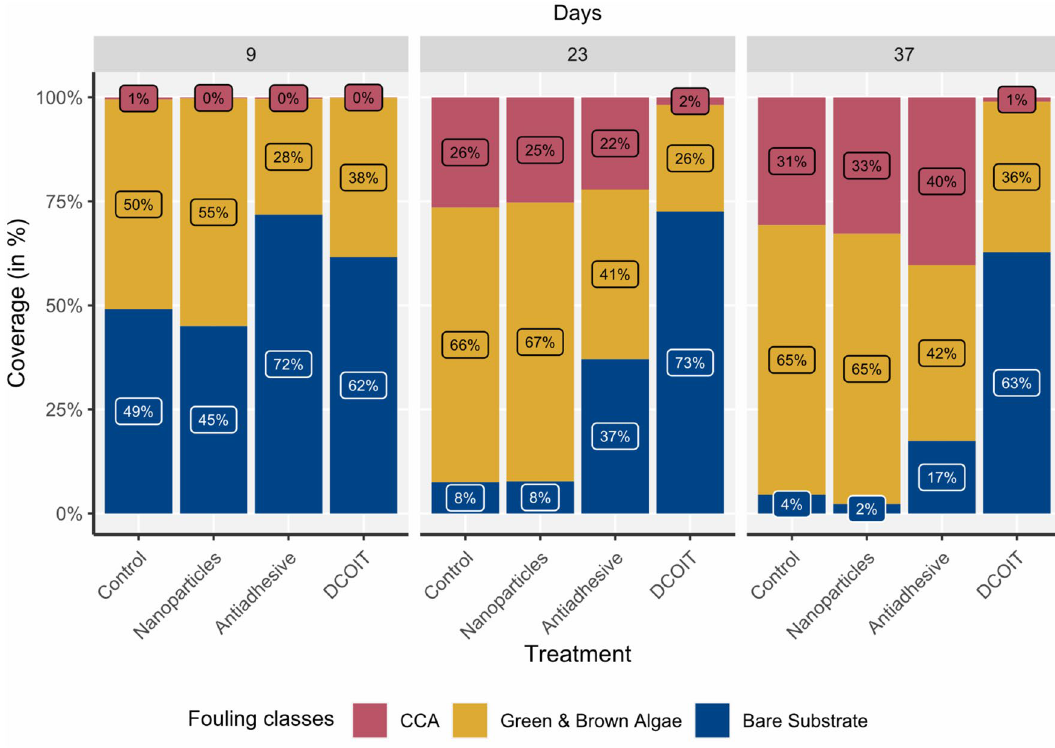
Figure 2. Fully-coated (FC) plugs (Nanoparticles, Antiadhesive, DCOIT) and uncoated Control plugs (n = 45 plugs per treatment) were incubated in semi-recirculating seawater systems prior to coral settlement trials to examine the mean coverage (%) of fouling classes (CCA, Green/brown algae, Bare substrate) over time (after 9, 23, 37 days). Note that bare substrate coverage at experimental start (day 0) was 100% (Supplementary Table